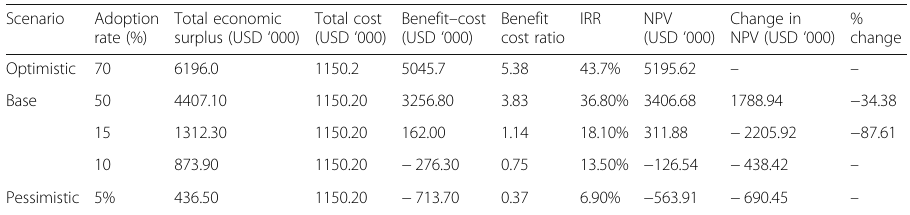
Table 5 Adoption rate sensitivity